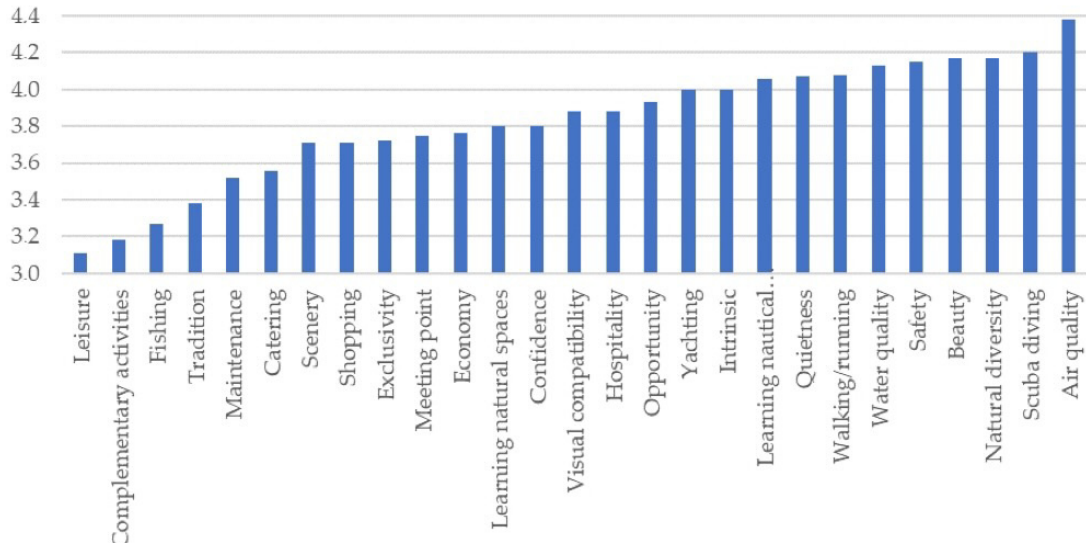
Figure 3. Ratings for landscape values.